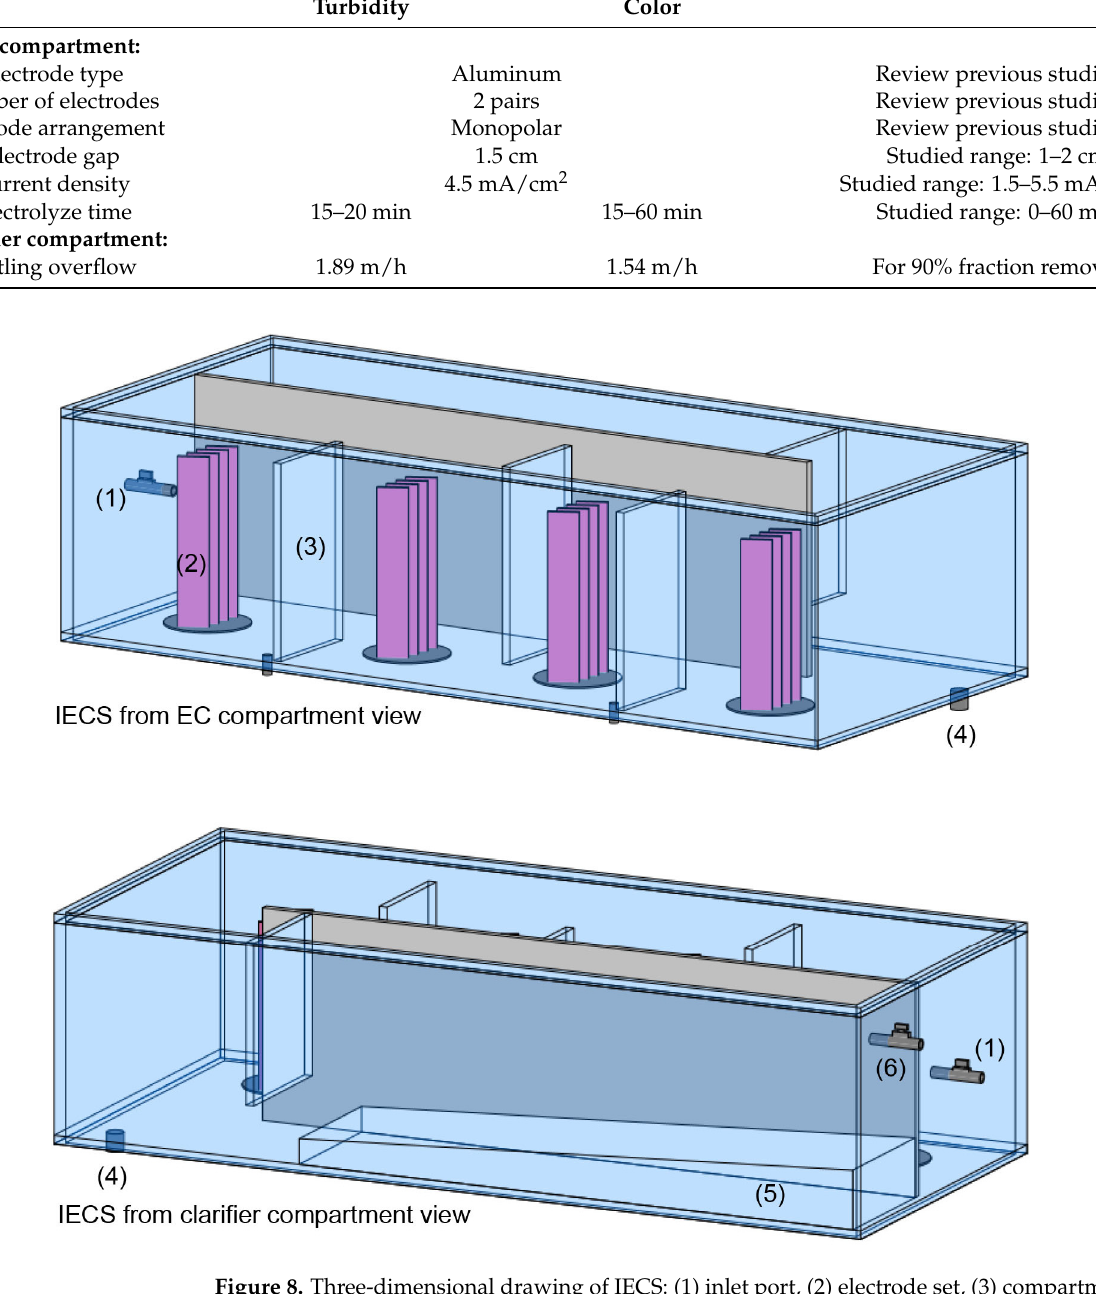
Figure 8. Three-dimensional drawing of IECS: (1) inlet port, (2) electrode set, (3) compartment baffle, (4) de-sludge port, (5) bottom slop of clarifier compartment, and (6) outlet port.